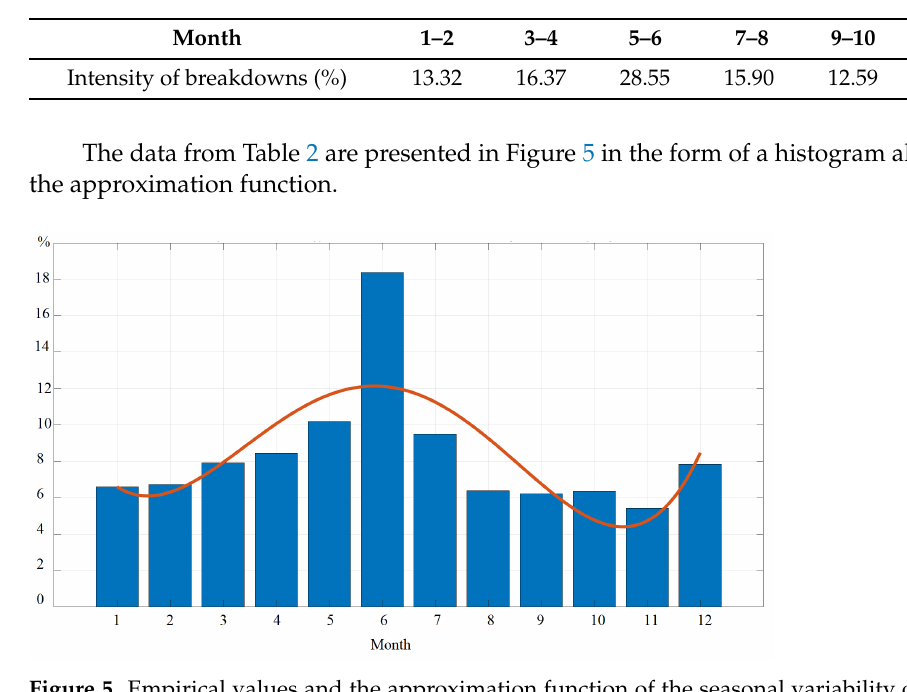
Table 2. Breakdown frequency of MV lines in their individual months through the years 2016–2020.